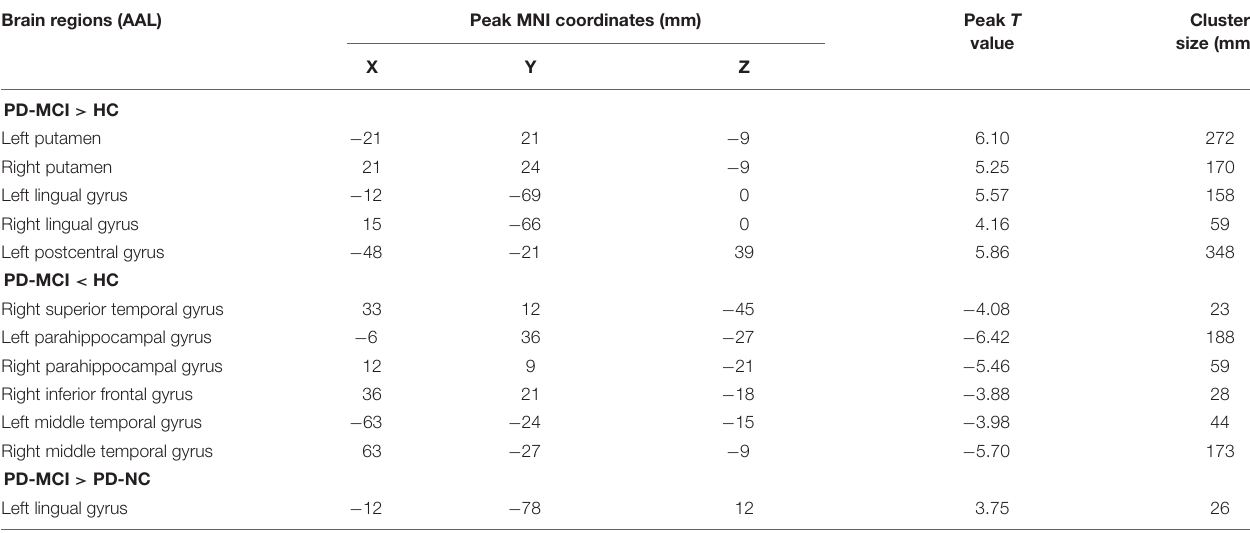
TABLE 4 | Descriptions of significantly different brain regions in the CBF-ReHo ratio between PD-MCI group and HC and PD-NC groups. Brain regions